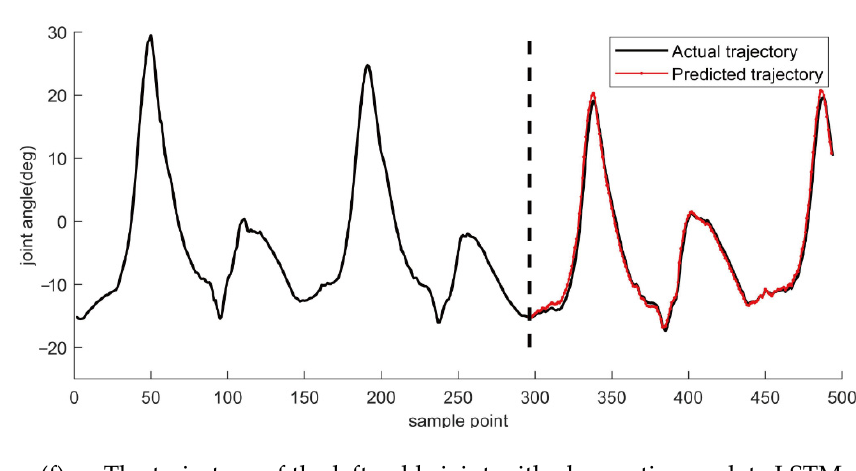
The trajectory of the left ankle joint with observation update LSTM Figure 4. The LSTM using an observation update for motion trajectory prediction. From the top to the bottom are the trajectories of the right hip, right knee, right ankle, left hip, left knee, and left ankle joints, respectively.